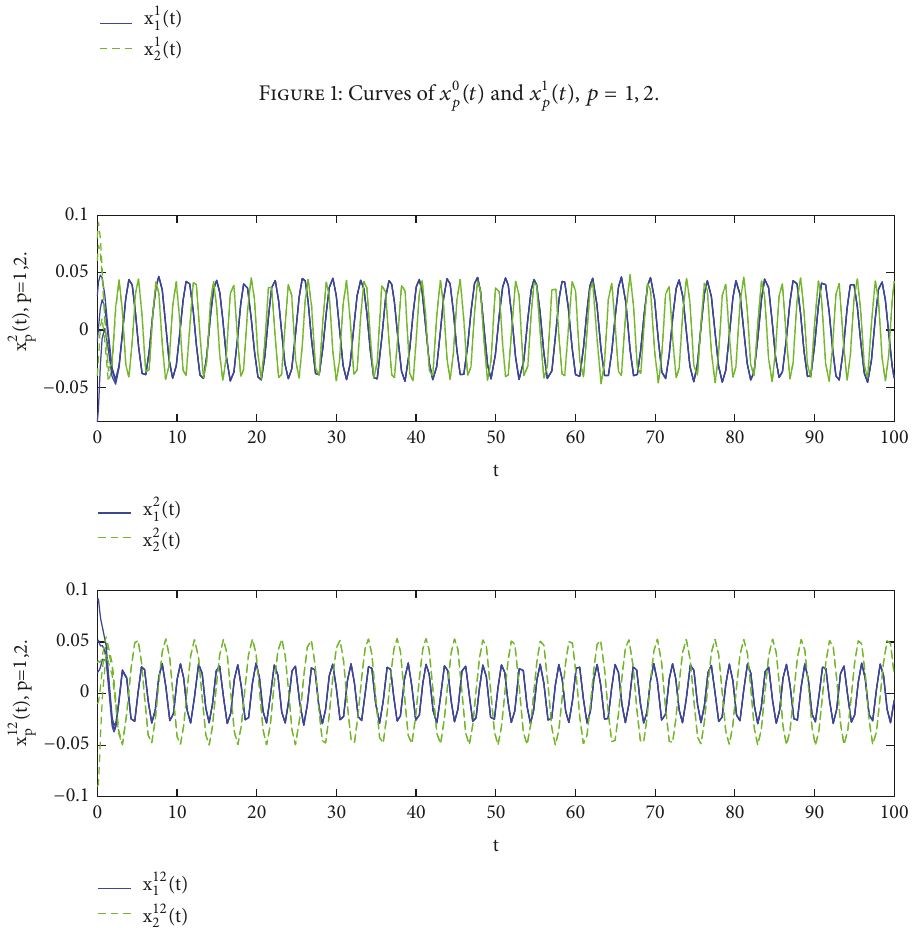
Figure 2: Curves of 𝑥 2 𝑝 (𝑡) and 𝑥 12 𝑝 (𝑡) , 𝑝 = 1, 2